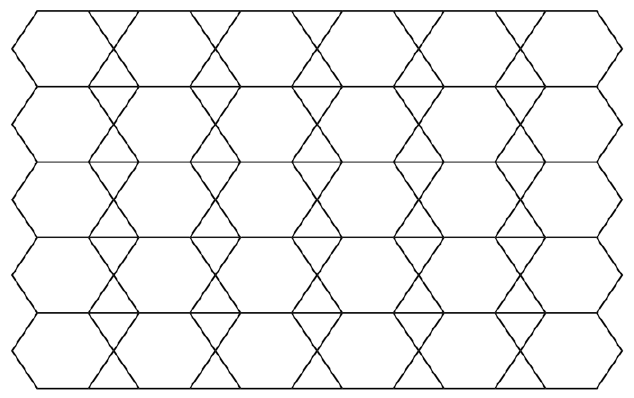
Figure 1. Chemical graph of nanosheet 𝐶[6,5] with five rows and six hexagons in each row.